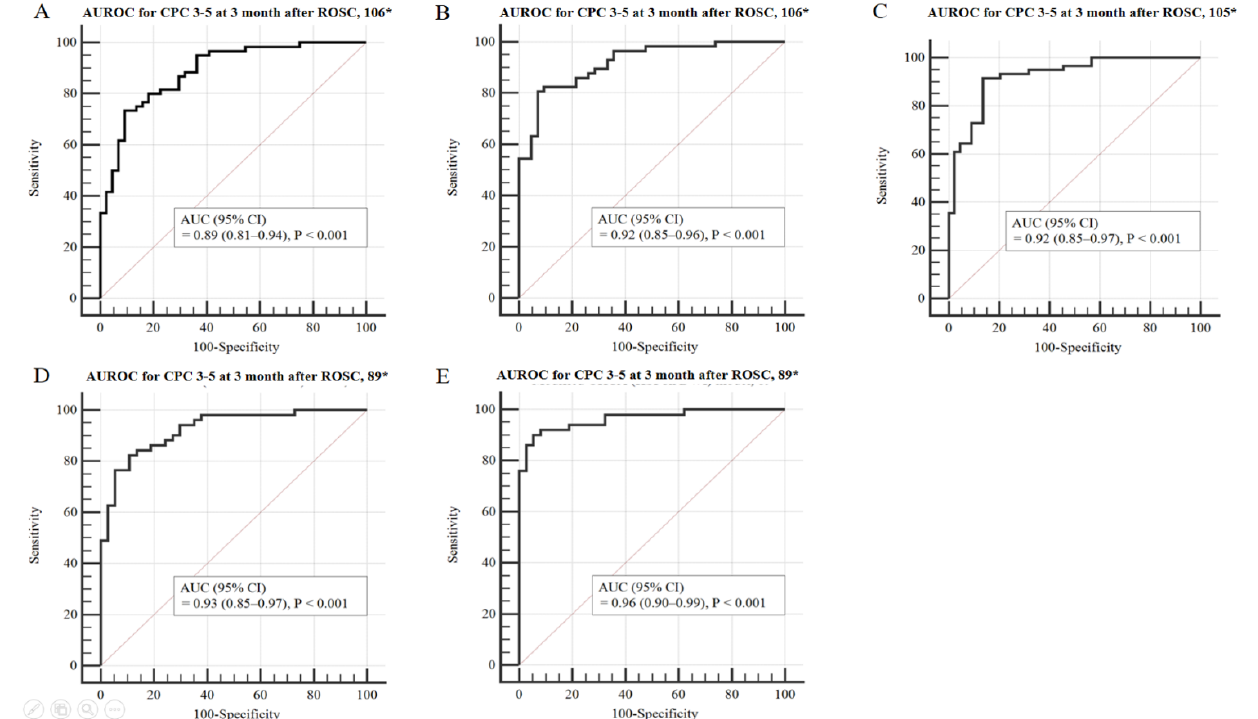
Figure 2. Area under the curve (AUC) to predict poor neurological outcome 3 months post-OHCA in the modified OHCA model. The ROC curve for the M-OHCA model is shown in panel ( A ); the ROC curve for the M-OHCA NSE model is shown in panel ( B ); the ROC curve for the M-OHCA GWR model is shown in panel ( C ); the ROC curve for the M-OHCA PV400 model is shown in panel ( D ); the ROC curve for the M-OHCA HSI model is shown in panel ( E ). Abbreviations: OHCA, out-of-hospital cardiac arrest; ROC, receiver operating characteristics; NSE, neuron-specific enolase; GWR, grey/white matter ratio; PV, percentage of voxel; HSI, high signal intensity; CI, confidence interval. * Number of patients included in the analysis.